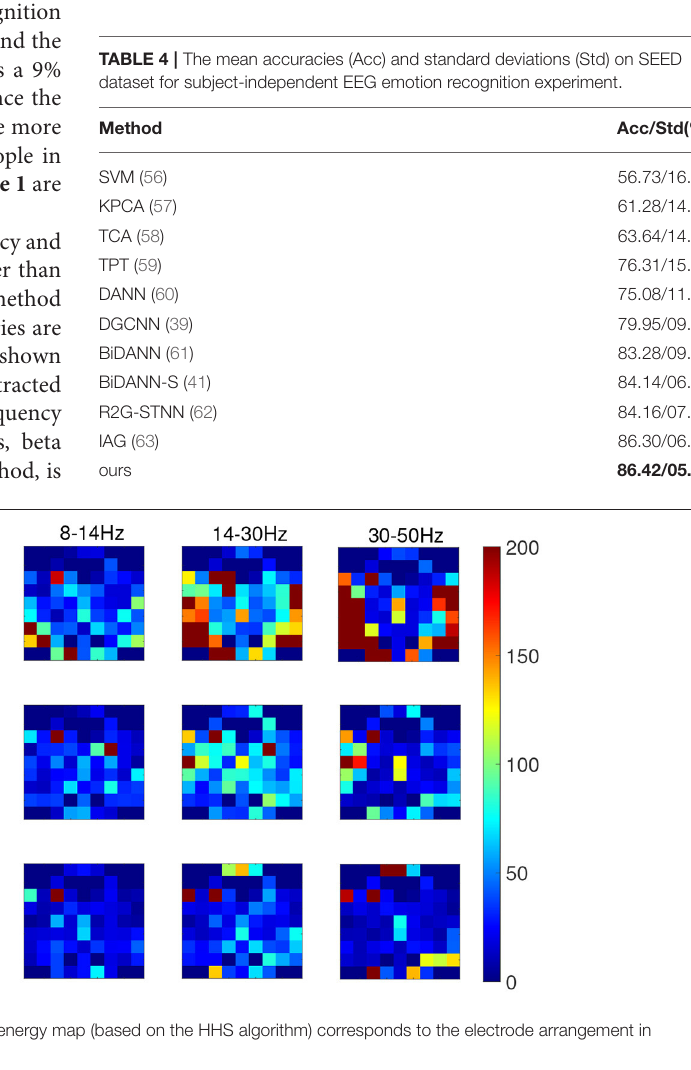
Frontiers in Psychiatry |